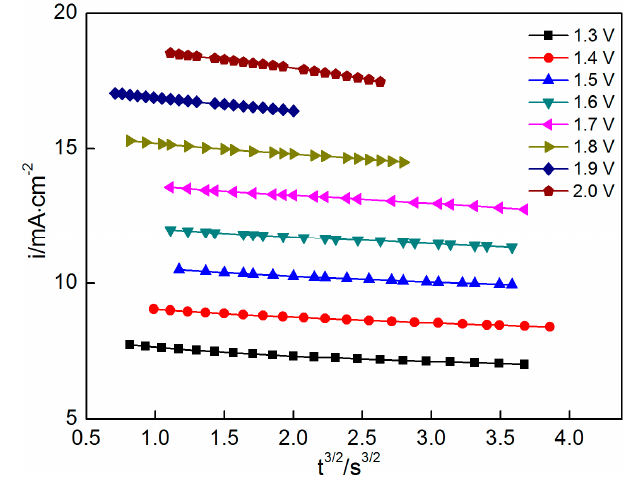
Figure 7. Current i as a function of t 3/2 at various potentials ranging from 1.3 V to 2.0 V.